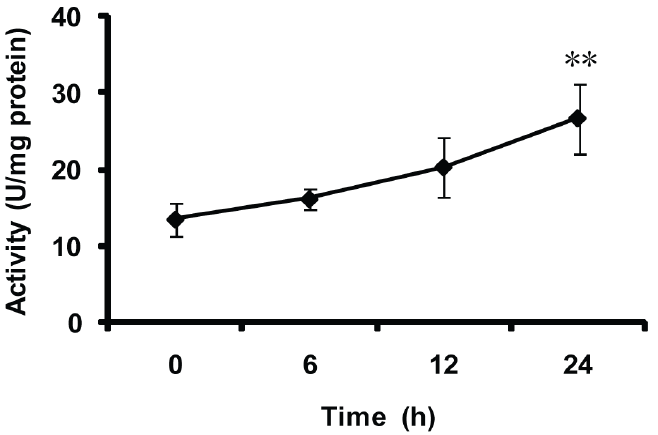
Figure 9. Effect of pesticide on MnSOD activity of whitefly in vivo . Each bar represents the mean ± SD ( n = 3). Significant differences between various times compared with 0 h are indicated by two asterisks at p < 0.01 (LSD